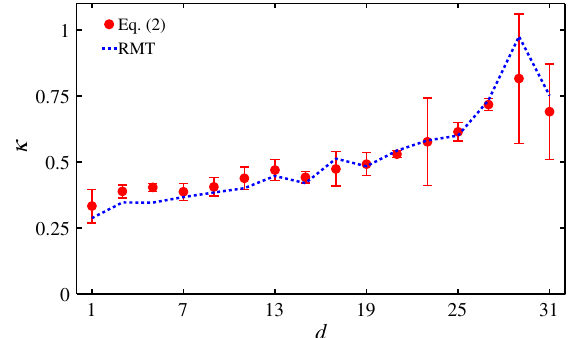
FIG. 4. Experimentally calculated coupling strength κ versus d : comparison between estimates from Eq. (2) (markers) and RMT theory (dashed line).